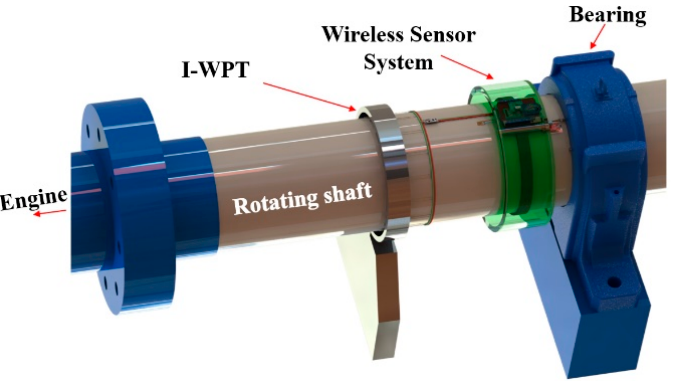
Figure 1. Installation of the WSS using the I-WPT unit on the rotating shaft.